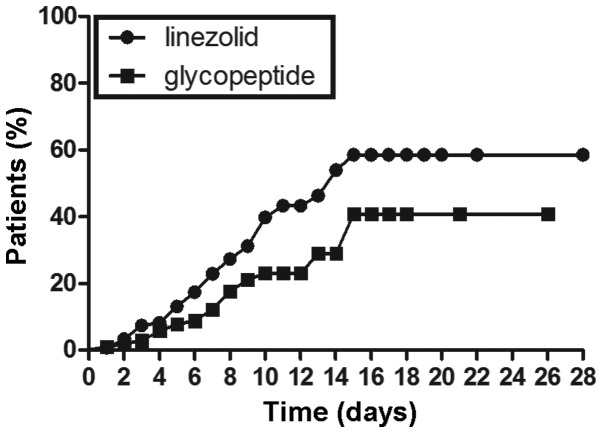
Kaplan-Meier plot of the probability of the number of platelets being <100×109/l. Log rank test P<0.001.